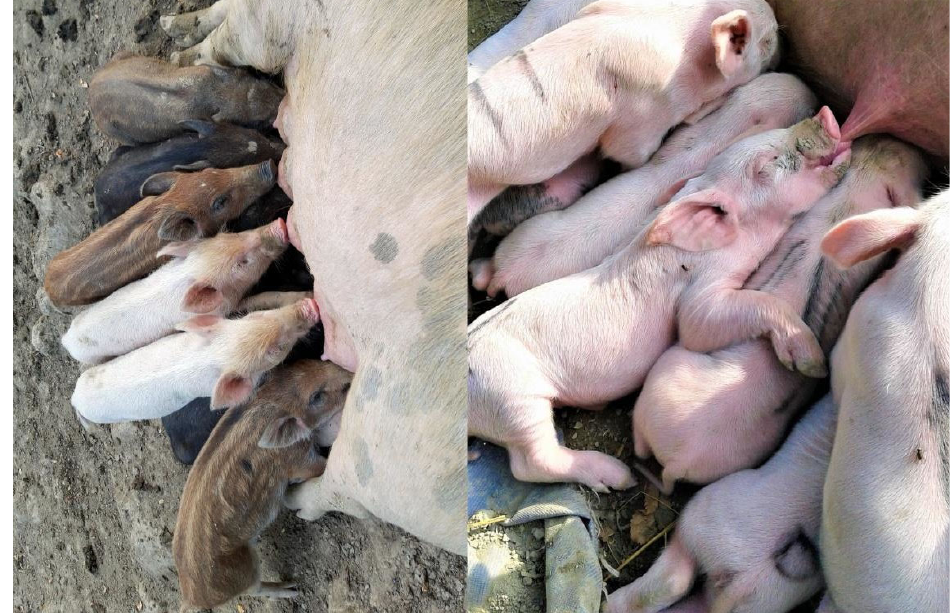
Figure 1. Wild boar hybrids ( left ) and piglets ( right ) during lactation (piglets are marked for individual identification).